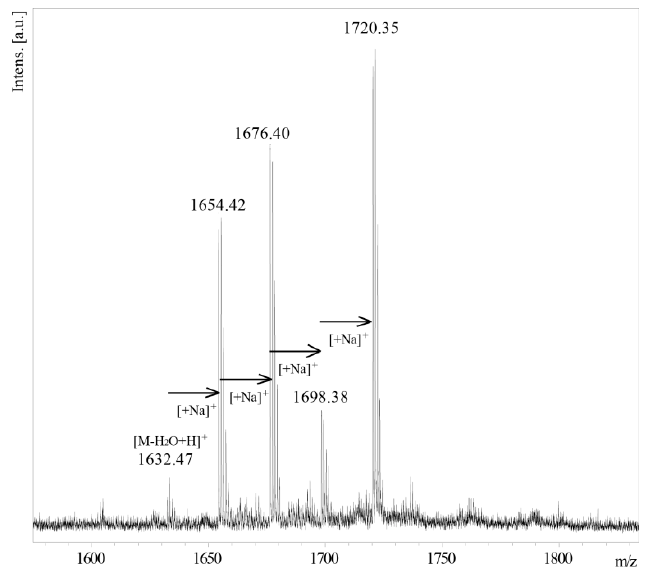
Figure 9. MALDI-TOF MS spectrum of OS VIII B. holmesii ATCC 51541 in positive reflectron mode with DHB as a matrix.